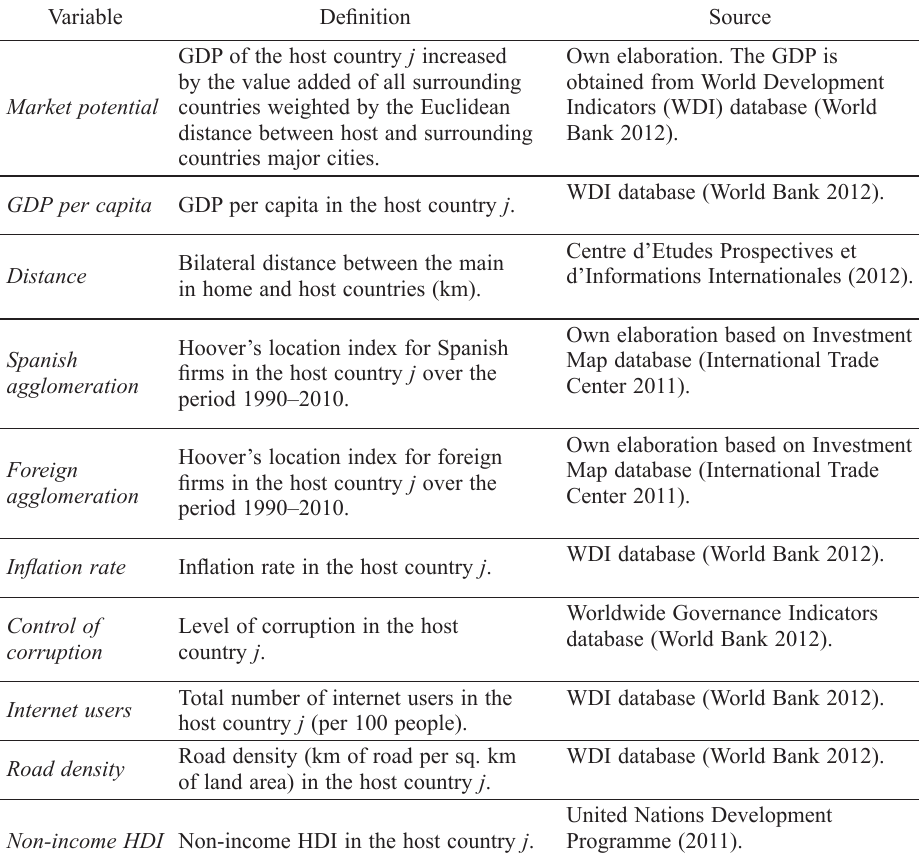
Table A.1. Summary and sources of the explanatory